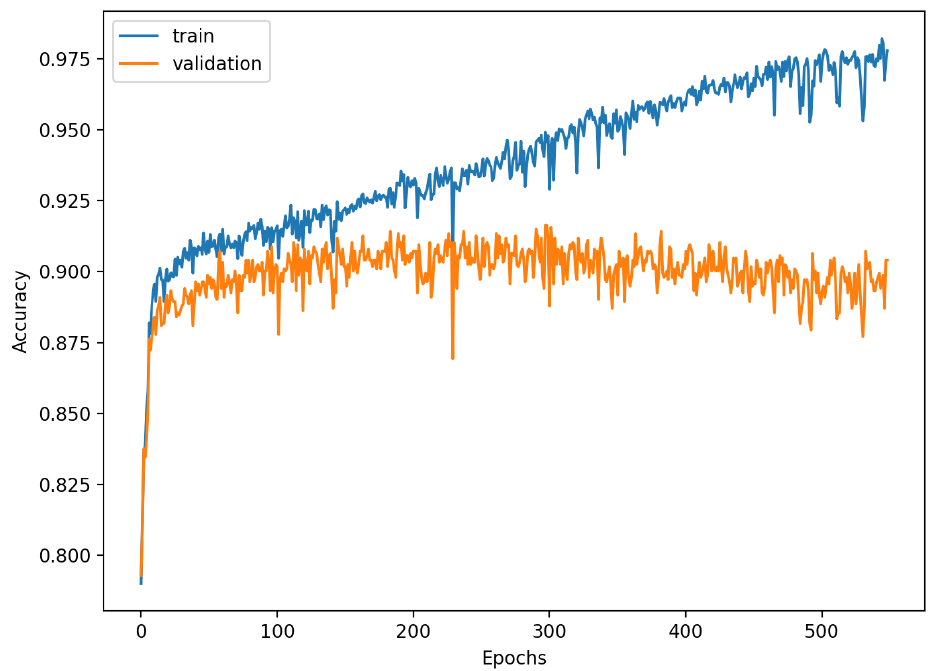
Figure 15. Learning process of the Neural Network for Few-Shot (2 classes) with proximity-based classification.